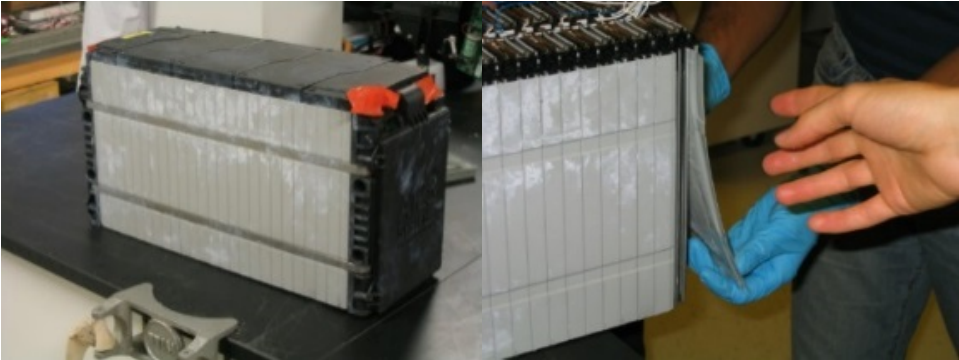
Figure 1. Reverse engineering approach: taking out battery cell from pack.